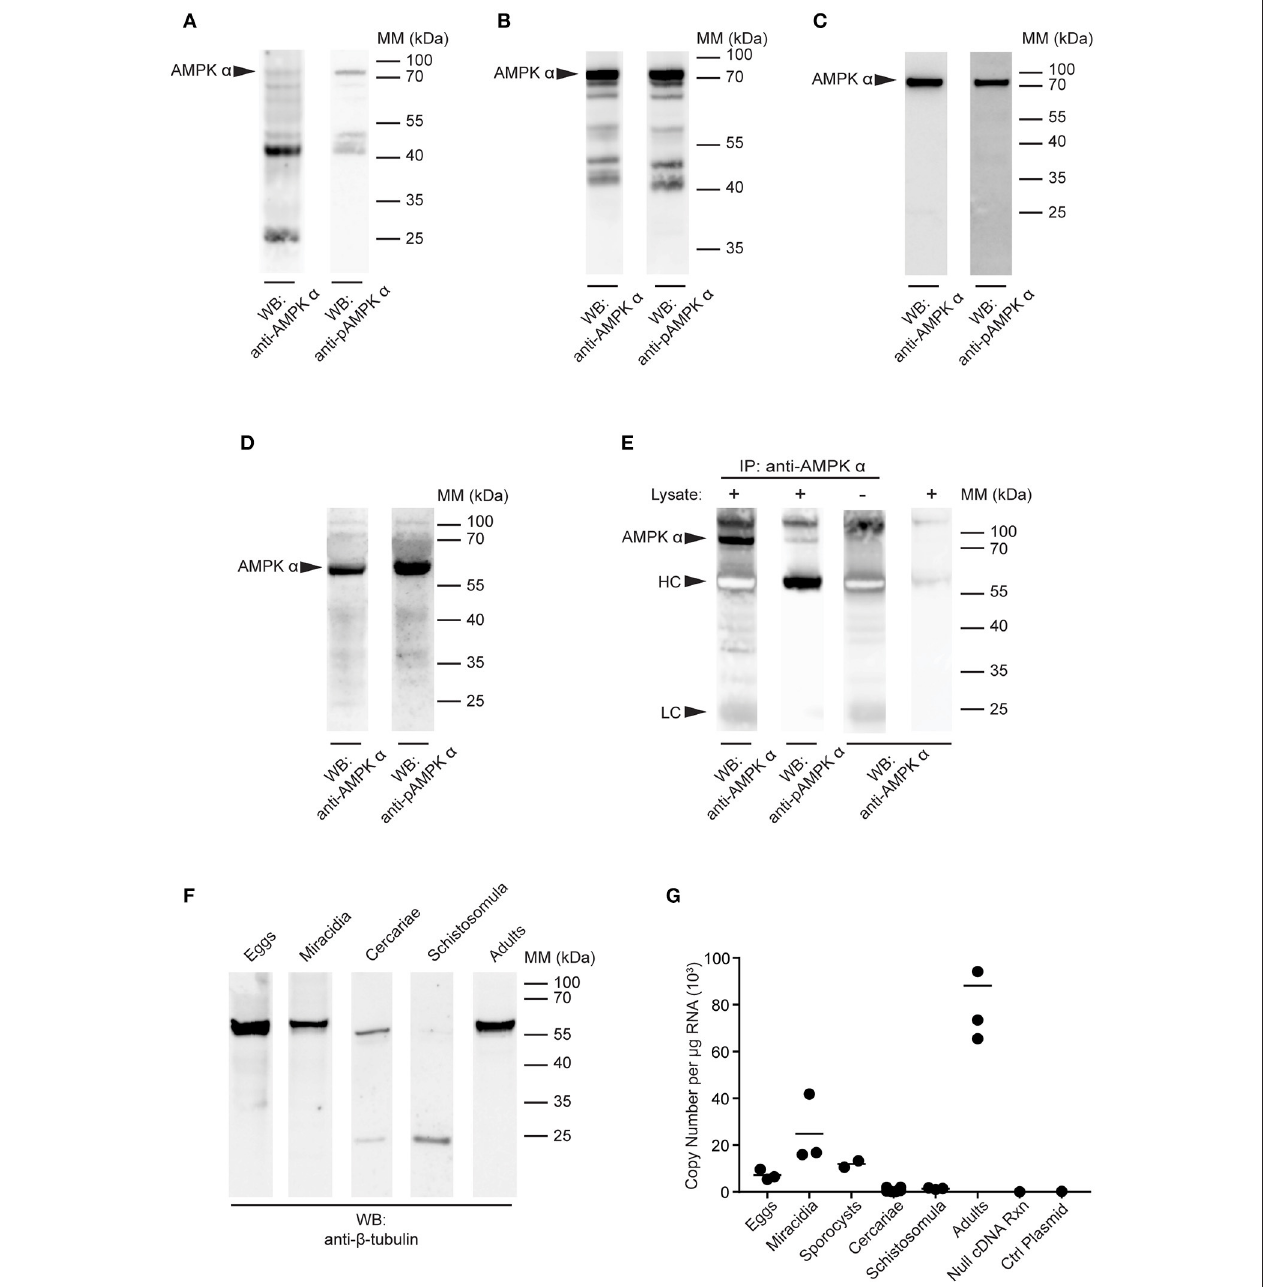
FIGURE 3 | Detection of AMPK α in S. mansoni larval stages. (A–D) Lysates of S. mansoni eggs (A) , miracidia (B) , cercariae (C) , and schistosomula (D) , 30min post-transformation were probed by Western blot using anti-AMPK α (left lane) and anti-pAMPK α (right lane) antibodies. (E) AMPK α was immunoprecipitated from schistosomula lysate using anti-AMPK α , then probed by Western blot using the anti-AMPK α and anti-pAMPK α antibodies. Control immnoprecipitations, where the either the lysate or the immunoprecipitating anti-AMPK α were omitted, were also probed with anti-AMPK α . Arrowheads indicate the position of the schistosome AMPK α (AMPK α ) and the immunoglobulin heavy chain (HC) and light chain (LC) of the immunoprecipitating antibody. (F) Lysates of each larval stage and adult worms were probed by Western blot with an anti- β -tubulin antibody. (G) AMPK α transcripts in each S. mansoni developmental stage were quantified using quantitative real-time RT-PCR. Control reactions containing no cDNA template and a control plasmid lacking the AMPK α target sequence were also included. WB, indicates the antibody used for Western blotting; IP, indicates the antibody used for immunoprecipitation; Positions of molecular mass (MM) markers, in kilodaltons (kDa), are indicated to the right of each